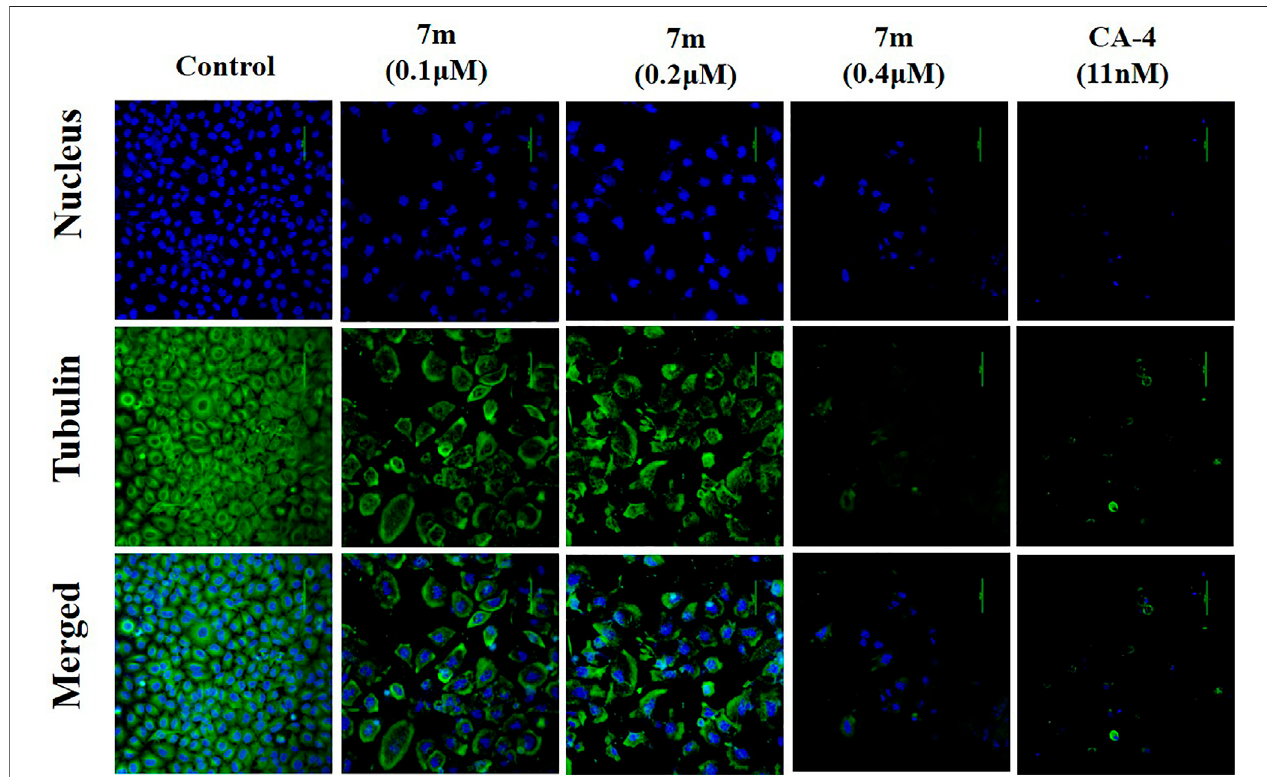
FIGURE5| Immuno fl uorescenceassayanalysisoftheeffectofcompound7monthecellularmicrotubulenetworkaftertreatmentwithDMSO(control)or7matthe indicated concentrations (0.1, 0.2, and 0.4 µM) for 24 h. Microtubules and unassembled tubulin are shown in green, and DNA is shown in blue.